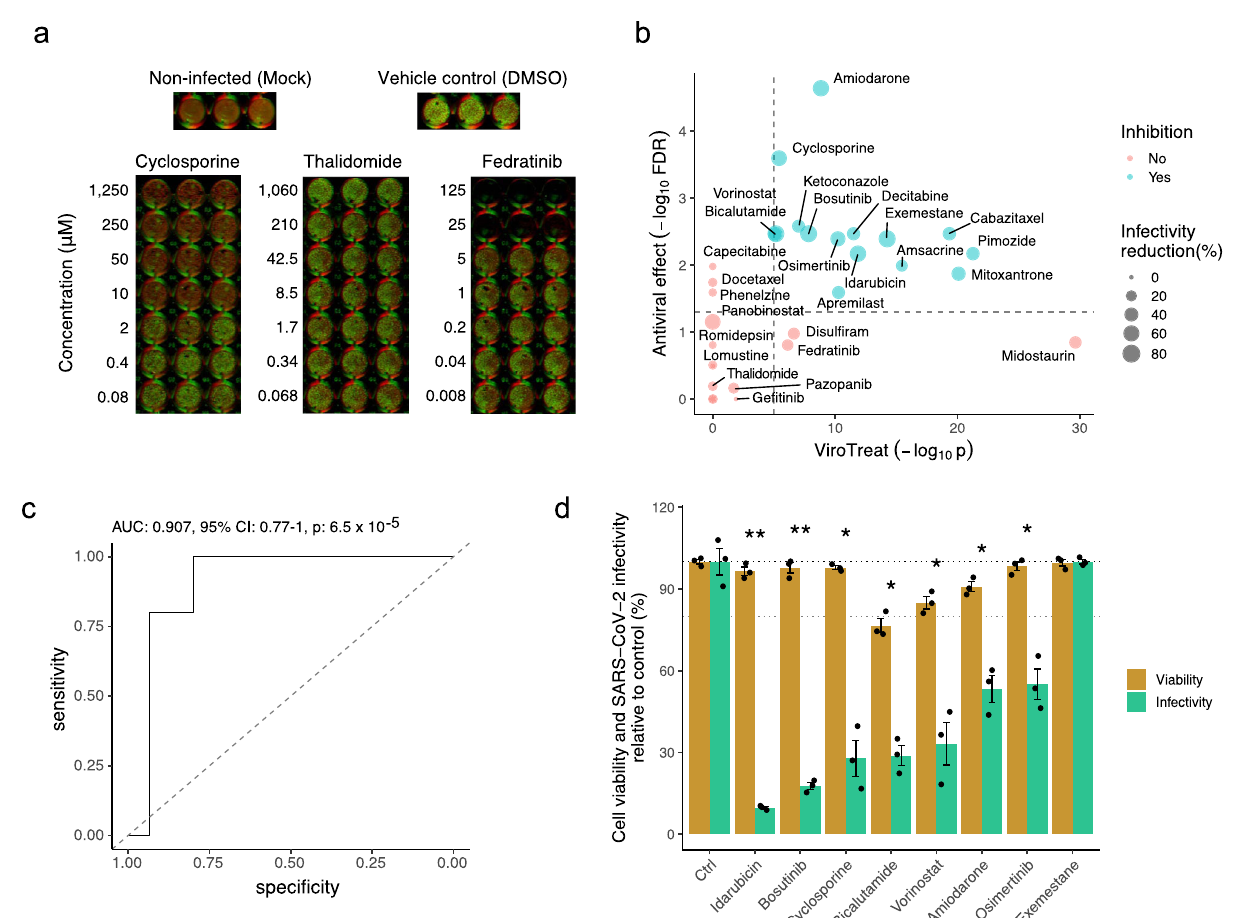
Fig. 4 Experimental validation of ViroTreat predictions. a Representative immuno fl uorescence images of non-infected (Mock) Caco-2 cells, vehicle control (DMSO) treated and SARS-CoV-2 infected cells, and representative examples of a drug showing signi fi cant antiviral effect (Cyclosporine), of a drug showing non-signi fi cant antiviral effect (Thalidomide) and a drug showing non-signi fi cant antiviral effect and cell toxicity (Fedratinib). Drug concentration ( μ M) is indicated to the left of the images showing triplicated experiments. Cells were stained with DNA dye Draq5 (red) and anti-dsRNA antibody (green). b Scatterplot showing the ViroTreat results (x-axis) compared to the speci fi c antiviral effect (y-axis) experimentally evaluated in Caco-2 colon adenocarcinoma cells. The vertical and horizontal dashed lines represent the thresholds for statistical signi fi cance for ViroTreat ( p -value = 10 − 5 , BC) and speci fi c antiviral effect (FDR = 0.05), respectively. c ROC analysis for the ViroTreat predictions, considering as positive response a speci fi c antiviral effect at FDR < 0.05 with at least 20% reduction in virus replication. Estimated AUC, 95% con fi dence interval (CI) and p -value are indicated in the plot. d Effect of 8 drugs, showing the strongest reduction in SARS-CoV-2 replication in Caco-2 cells, on cell viability and SARS-CoV-2 replication in GI organoid-derived 2D primary cell cultures. Bars indicate the mean ± SEM. Antiviral effect: *FDR < 0.05, **FDR < 0.01. Source data in Supplementary Data 4 and